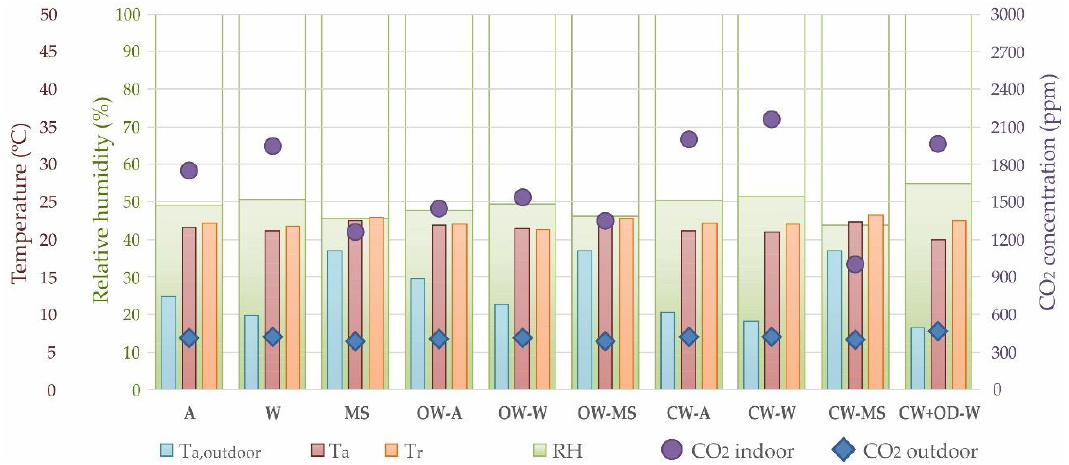
Figure 6. Indoor and outdoor air temperature values (T a ), mean radiant temperature values ( t 𝑟 ̅ ), relative humidity (HR) values and indoor and outdoor CO 2 concentration values related to seasons and windows’ and doors’ operation.